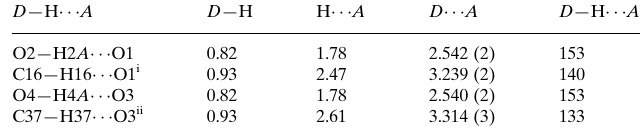
Hydrogen-bond geometry (A˚ , (cid:2)